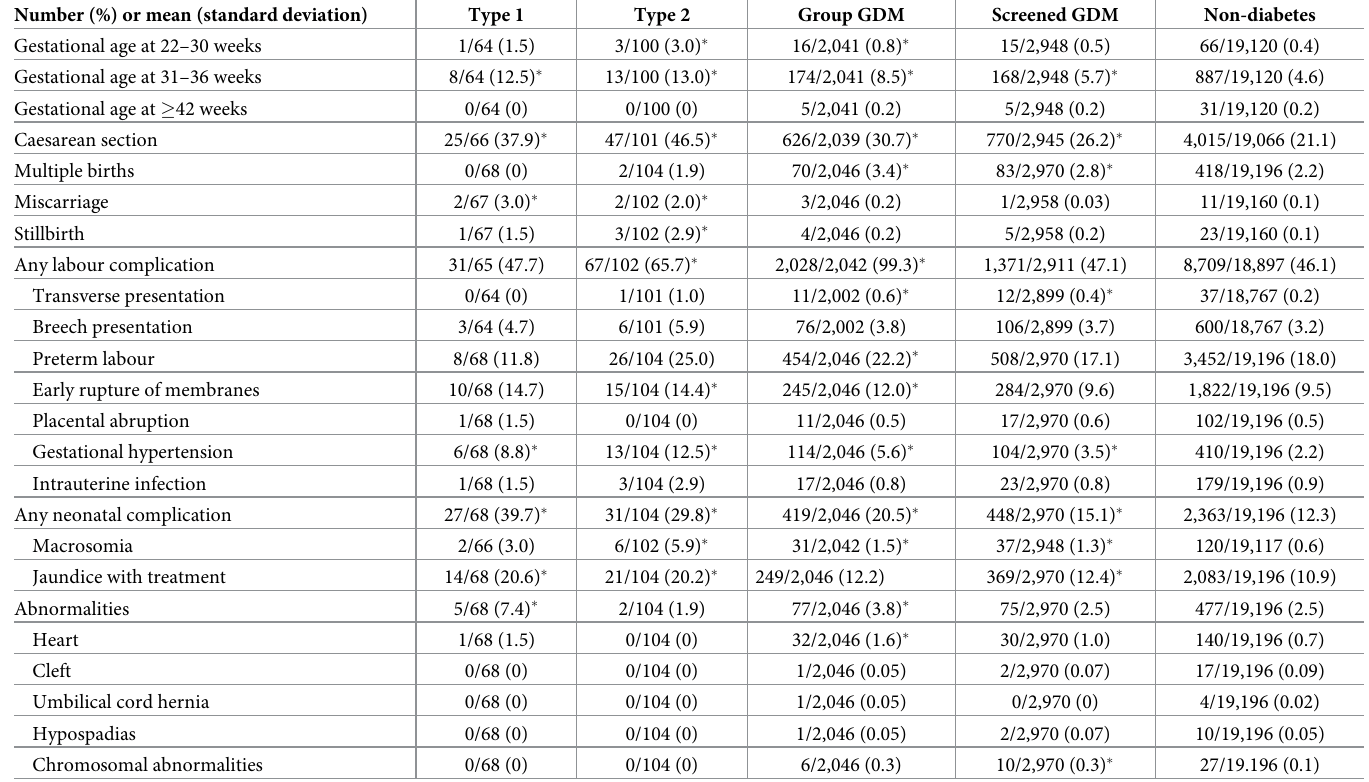
Table 2. Perinatal data of neonates of mothers with various types of diabetes and those without diabetes. Number (%) or mean (standard